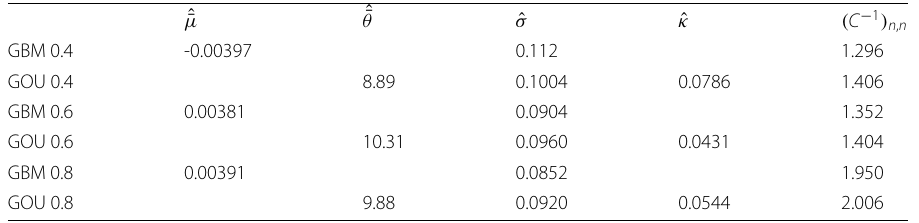
Table 4 Parameter estimates for the simulated GBM and GOU processes shown in Fig.